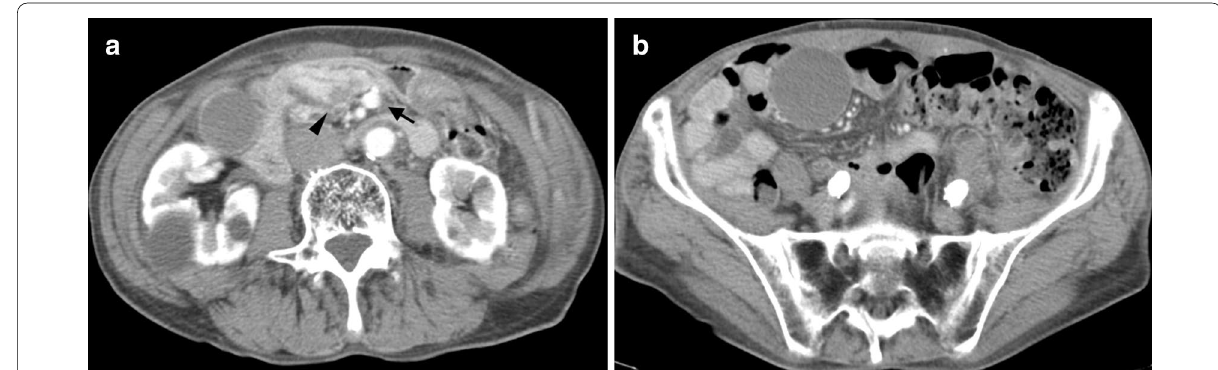
Fig. 1 Computed tomography findings. a A 25-mm low-density mass located in the pancreatic head (arrowhead). The superior mesenteric vein (SMV) was located to the left of the superior mesenteric artery, showing the SMV rotation sign (arrow). b The small bowel was located in the right abdomen, and the large bowel was located in the left abdomen